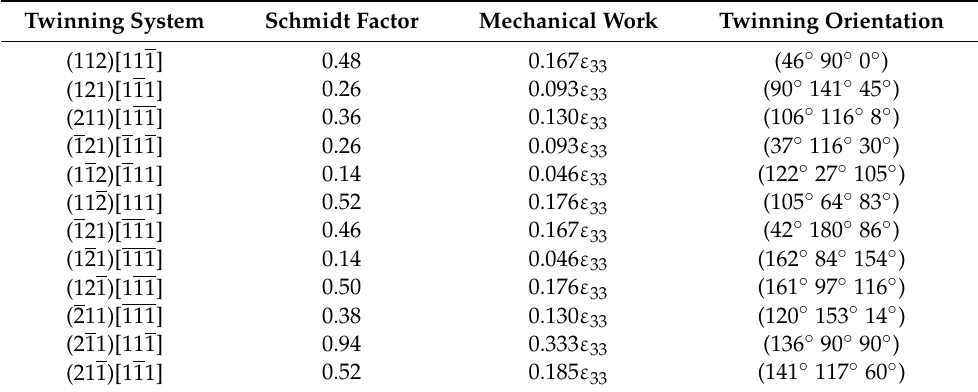
Table 1. The Schmid factor, shear mechanical work of twins in the deformed matrix with orientation of (18 ◦ 48 ◦ 153 ◦